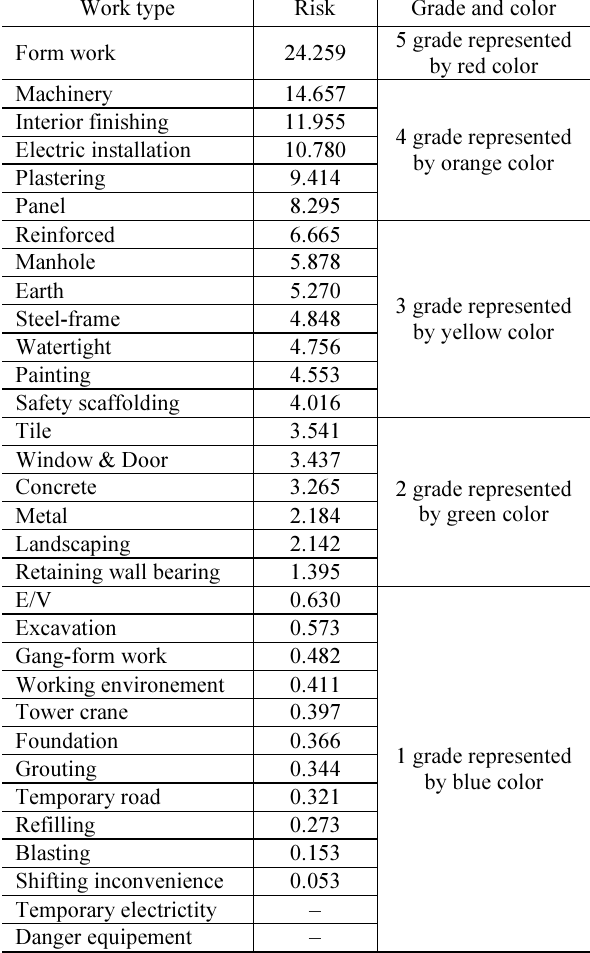
Table 1. Risk Assessment by work